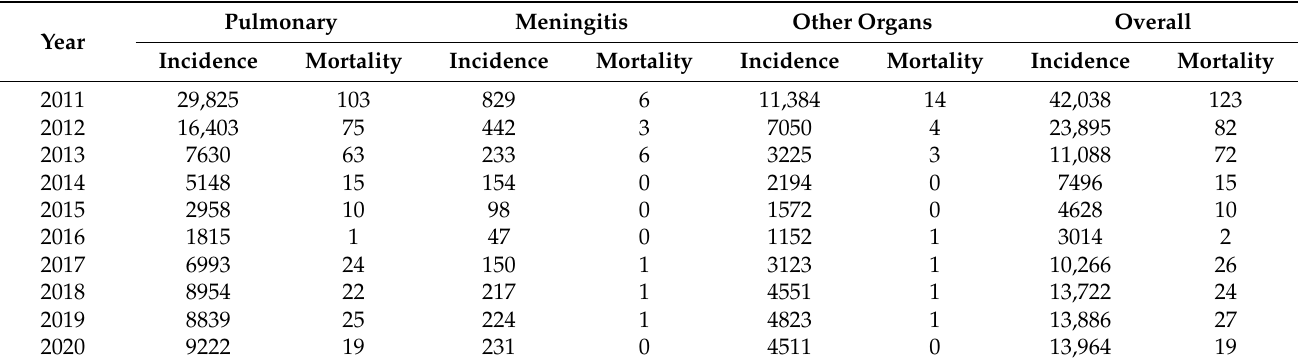
Table 1. Annual TB cases and deaths by type of infection notified in the surveillance system during